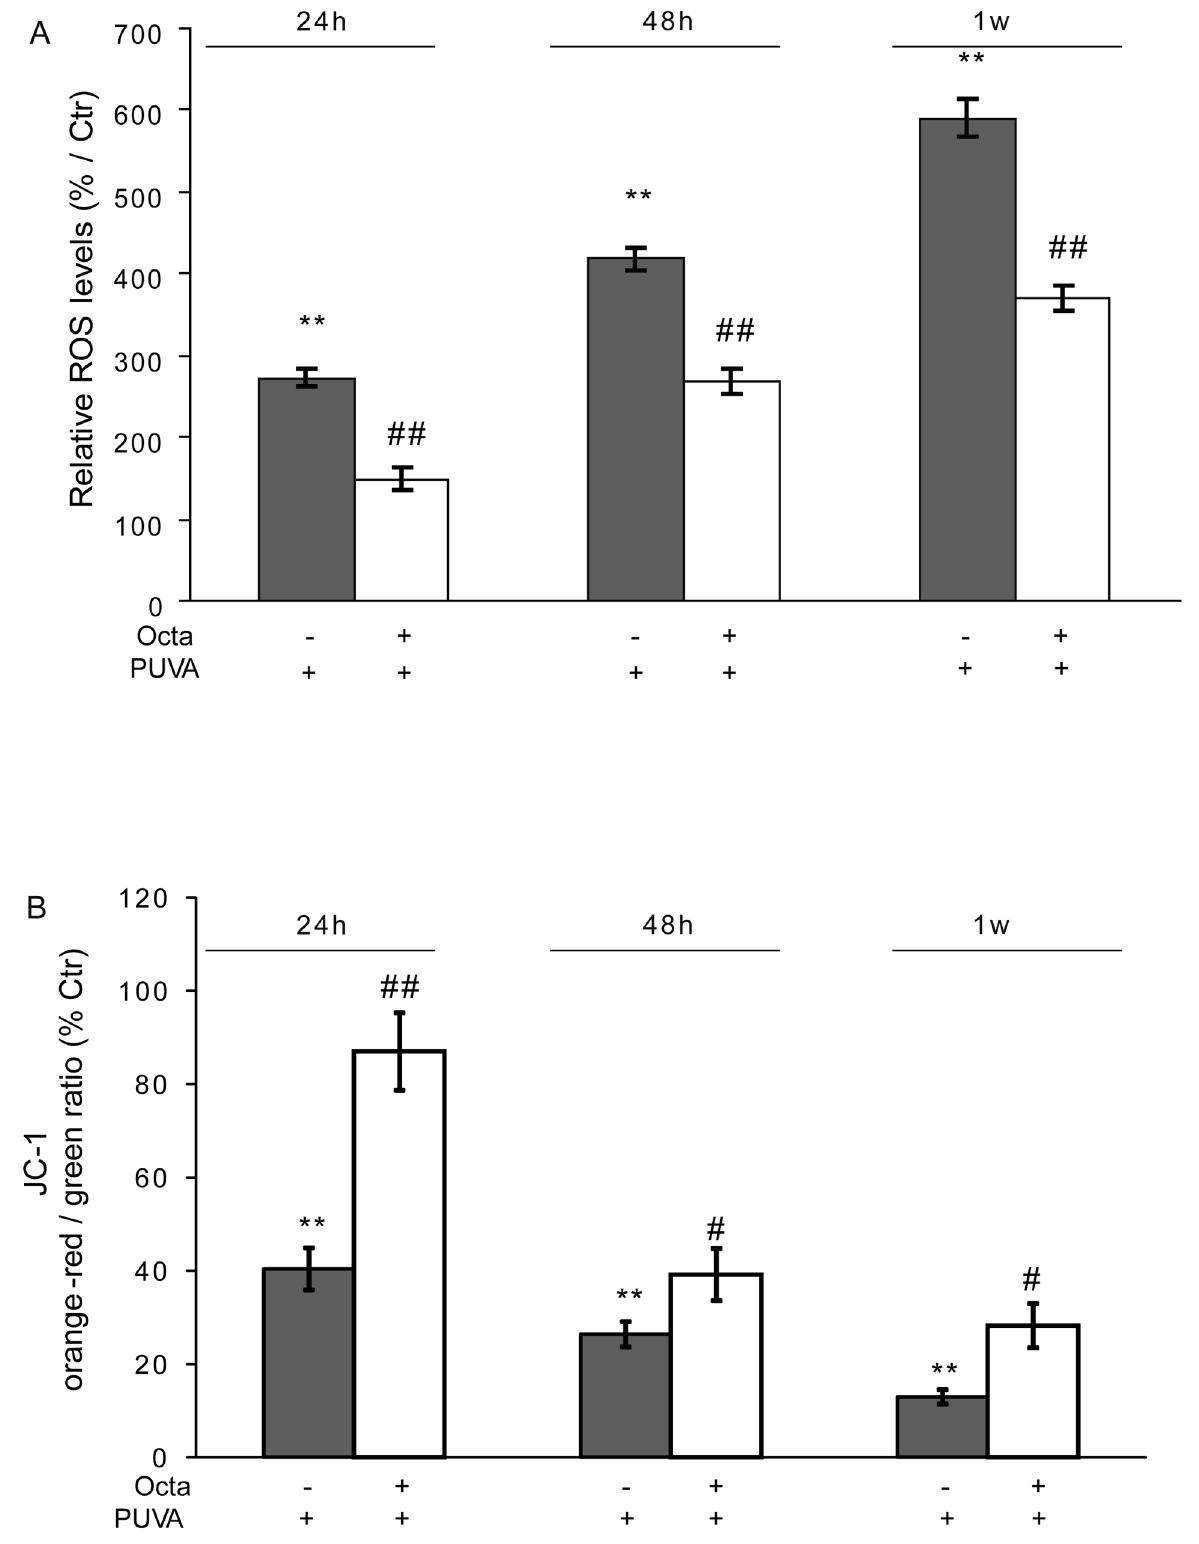
Figure 3. Effects of PPAR c modulation against PUVA-induced intracellular ROS accumulation and mitochondria damage. HDFs were treated with PUVA or left untreated (Ctr). Immediately after irradiation PBS was replaced by fresh medium with or without Octa 2 m M for 24 h, 48 h or 1 week. (A) Intracellular oxidative stress was assessed by Flow cytometry using the fluorescent probe DCFH 2 -DA. The median value of fluorescence was used to evaluate the intracellular content of DCF as a measure of the ROS formation. (B) DY m was assessed in live HDFs using the lipophilic cationic probe JC-1. For quantitative fluorescence measurements, cells were rinsed once after JC-1 staining and scanned with a Flow cytometer **p , 0.001 statistically different from unirradiated cells; ## p , 0.001 compared with PUVA-treated fibroblasts. doi:10.1371/journal.pone.0104045.g003 PLOS ONE |